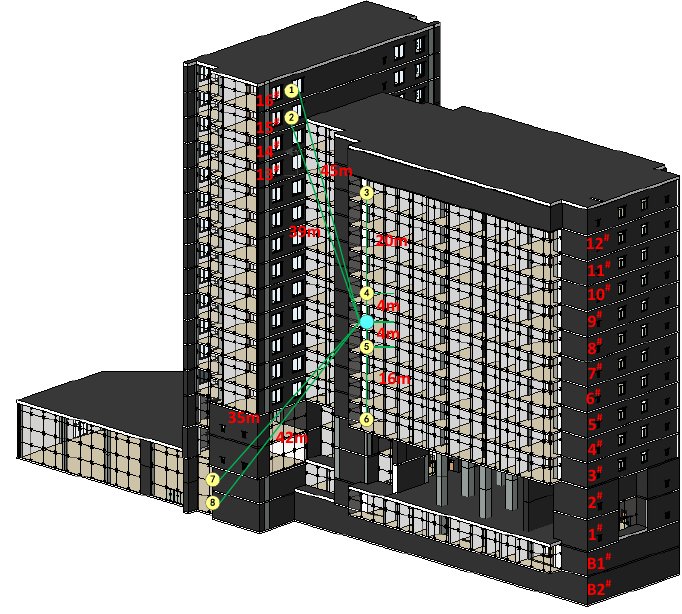
Figure 3. Model diagram of the measured building.